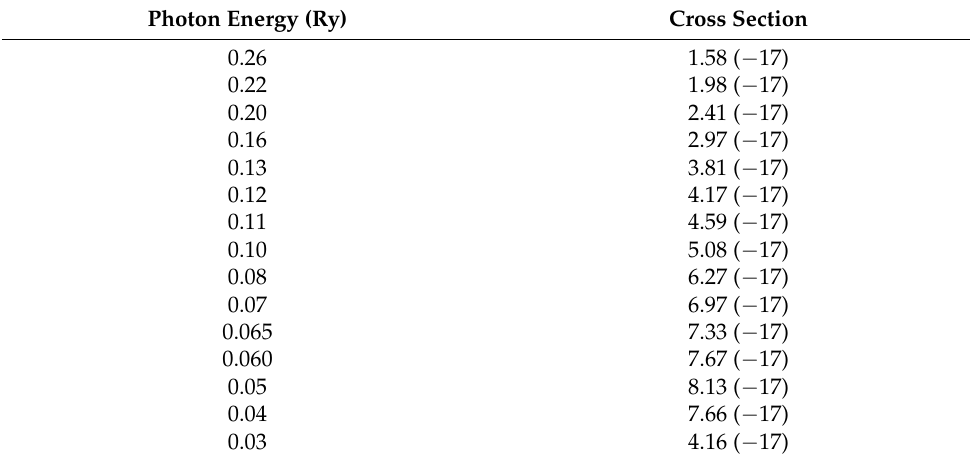
Table 13. Photodetachment. Cross sections (cm 2 ). Photon Energy (Ry) Cross